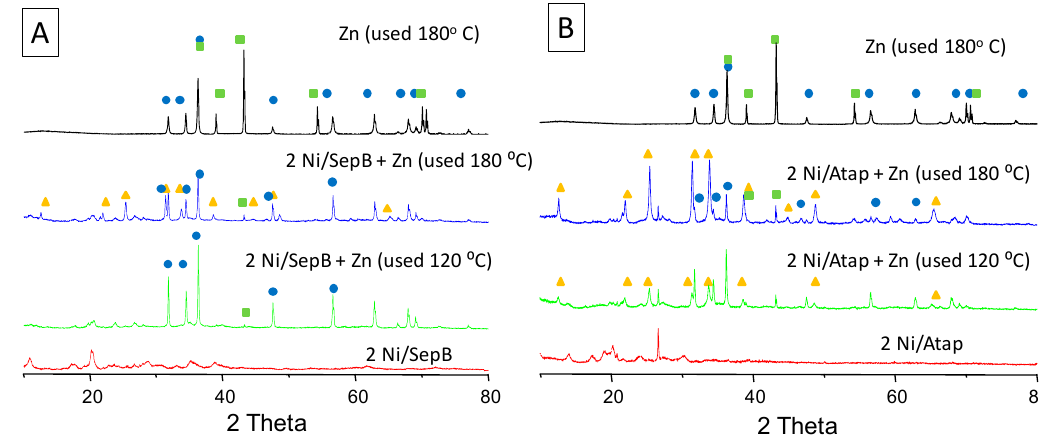
Figure 6. XRD patterns of 2Ni/SepB ( A ) and 2Ni/Atap ( B ): fresh, after use at 120 °C with Zn and after use at 180 °C with Zn. For comparison the XRD pattern of Zn used at 180 °C has been also included. Symbols: ( ■ ) Zn 0 , ( ● ) ZnO, ( ▲ ) Zn 2 SiO 4 .